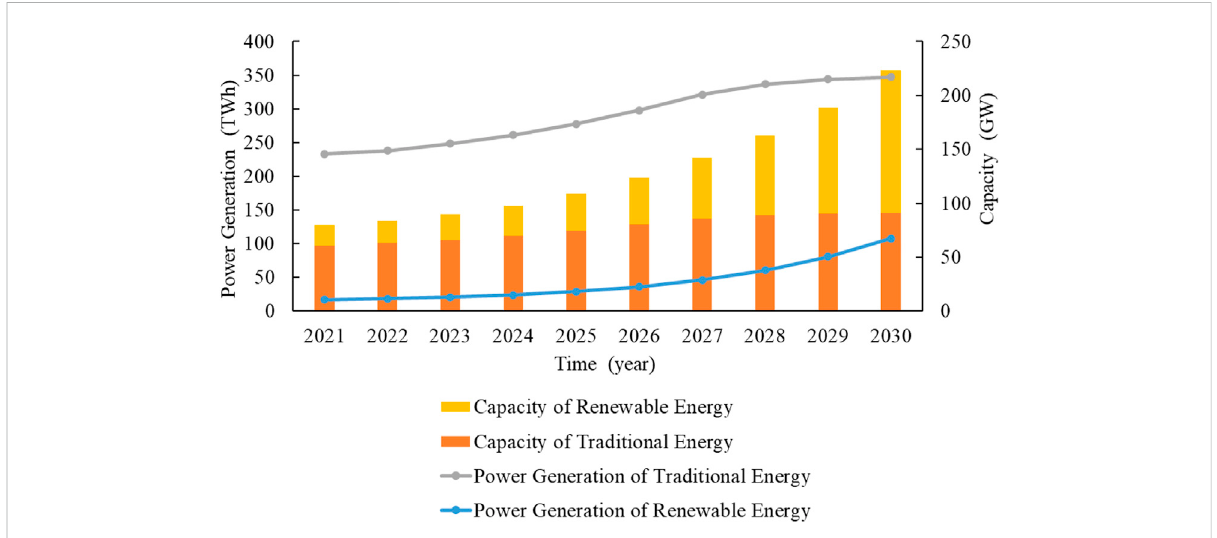
FIGURE 4 Energy structure and power generation.